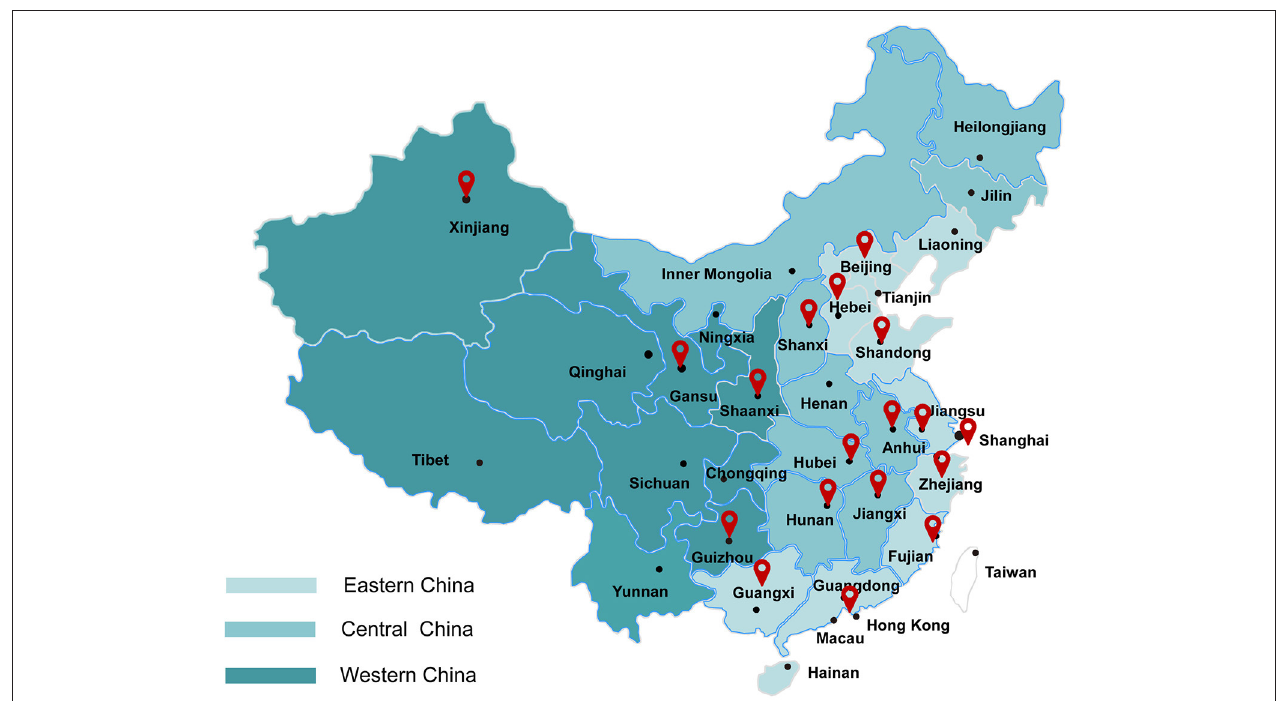
FIGURE 1 | Geographical distribution of eastern, central, and western regions in China and locations of the participating hospitals (1, 2). Eastern China: Shanghai First Maternity and Infant Hospital; Qingdao Women and Children’s Hospital; Women’s Hospital of Nanjing Medical University; Qilu Children’s Hospital of